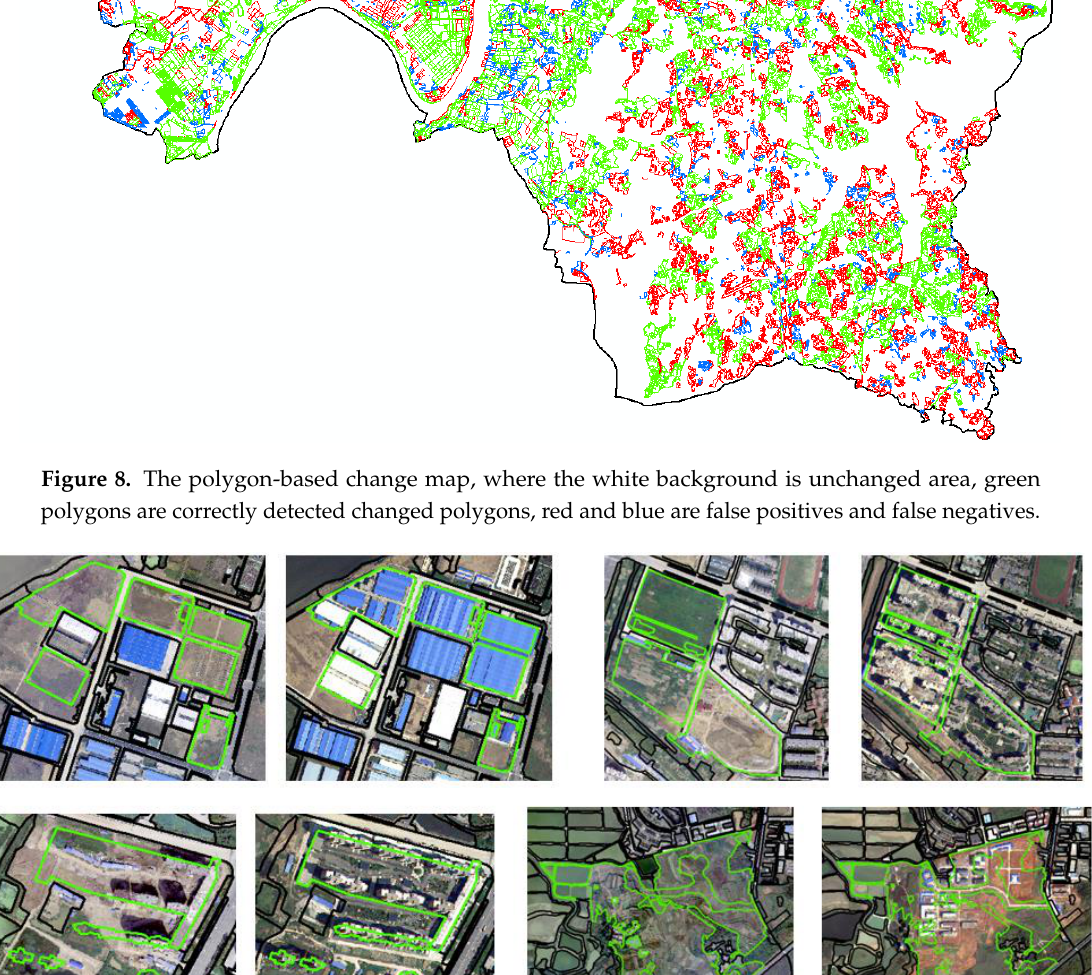
Figure 9. Four examples of polygon-based change maps. Green polygons overlaid on the 2014 and